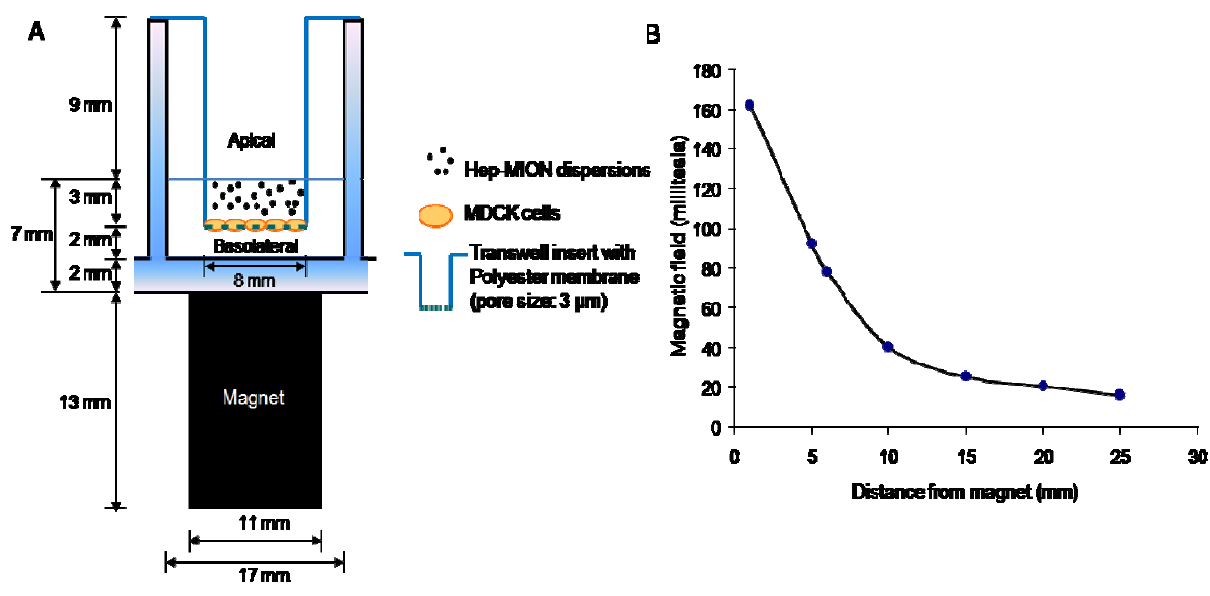
Figure 3. Diagram of the experimental set up. (A) The cells were seeded on the polyester membrane (pore size: 3 µm) in Transwell inserts. One magnet (11 mm × 13mm) was placed beneath the well. Hep-MION dispersions were added into the apical compartment (donor chamber) to be transported through the porous membrane into the basolateral compartment (receiver chamber) containing transport buffer. Lengths and widths of the insert in the 24-well plate and magnet are displayed as millimeters. (B) Applied magnetic field of the magnet decreases with the increasing distance from the magnet. A 3-axis Hall Teslameter (THM 7025, GMW Associates, San Carlos, CA) was used to measure the magnetic field. X-axis of the graph represents the vertical distance from the magnet’s surface.